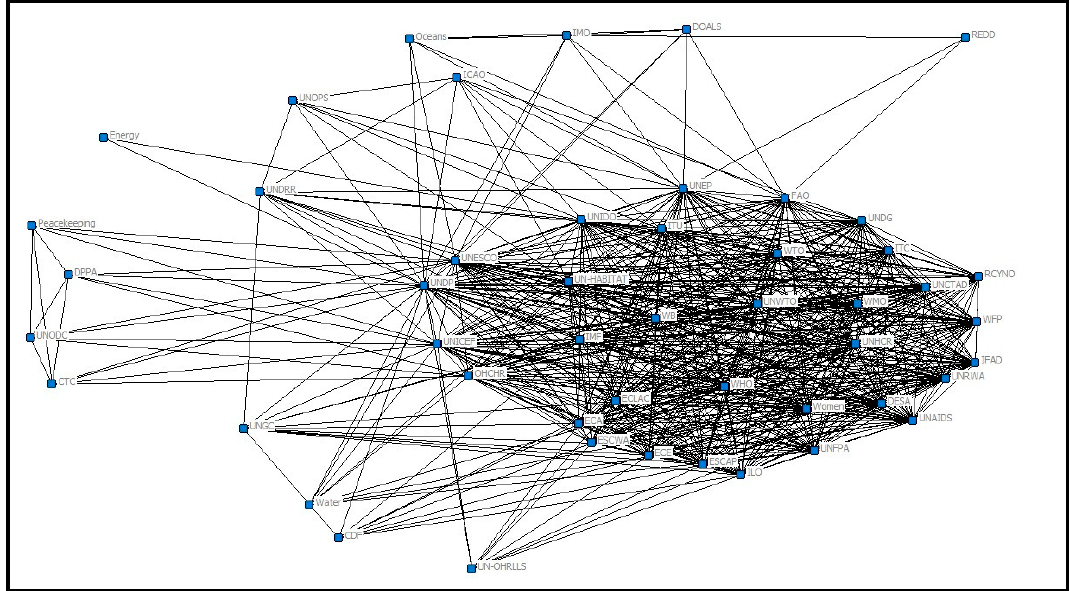
Figure 1. Organizations—whole network.